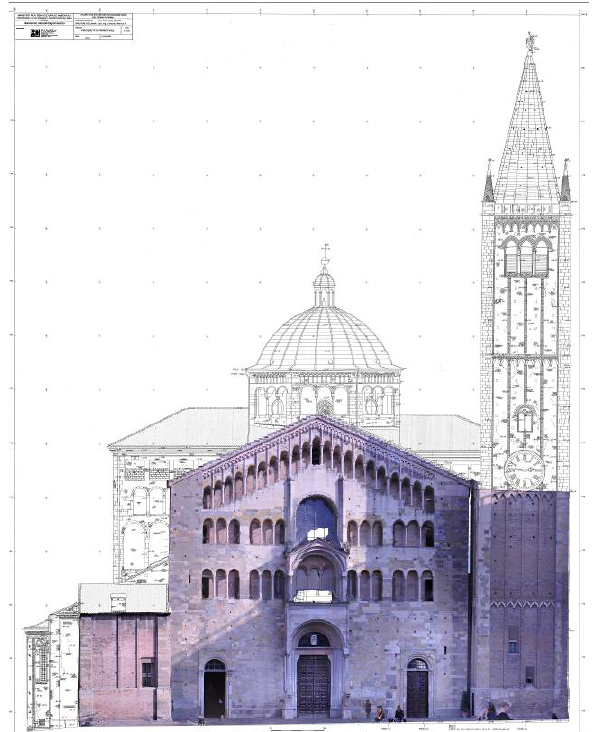
Figure 5_Orthophoto of the Cathedral main façade overlapped to the drawings of the photogrammetric survey made by FOART in